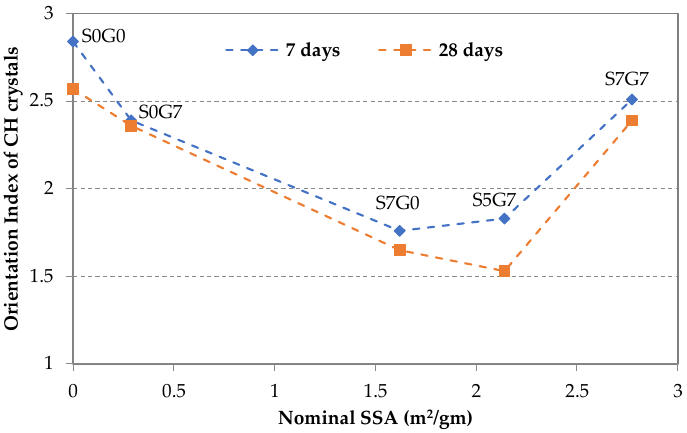
Figure 9. Orientation index of CH crystals.